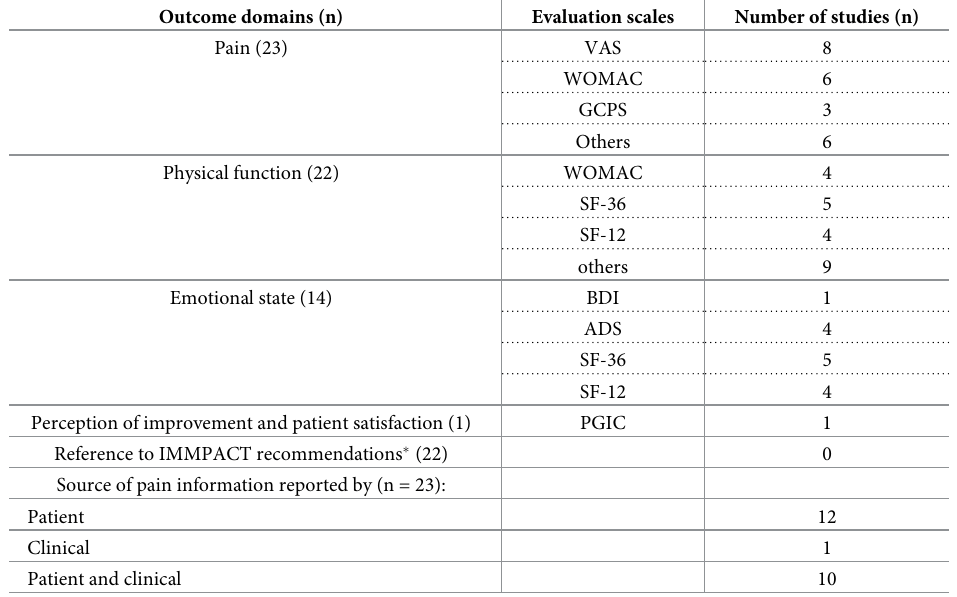
Table 3. Domains recommended by IMMPACT, instruments used in the included studies and source of informa- tion on the pain